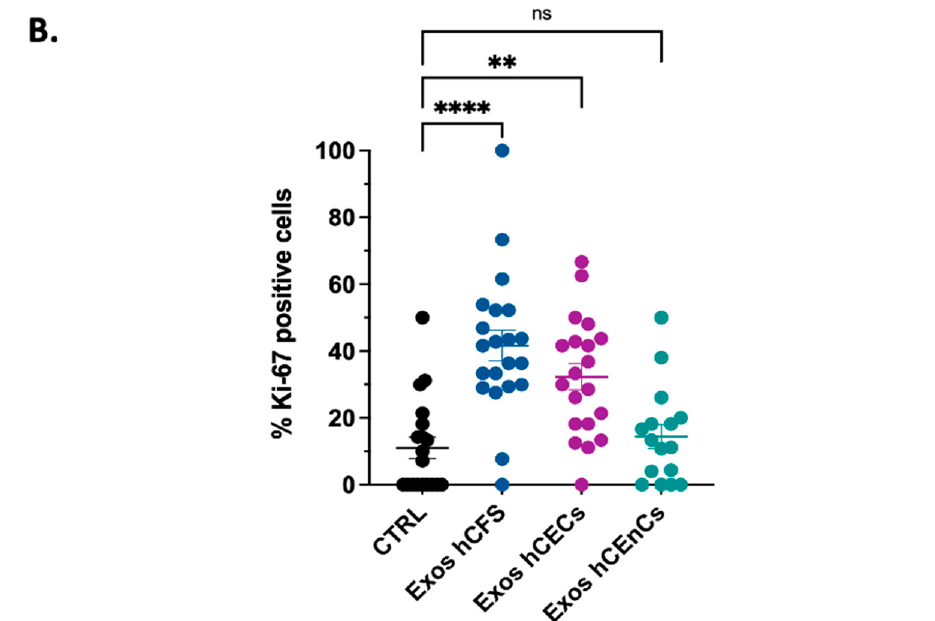
Figure 3. Effect of exosomes from the three corneal cell types on hCECs proliferation. hCECs were incubated with 800–1000 µ g exosomes isolated from medium of hCFs, hCECs and hCEnCs conditioned for 48 h. HBS was used as control (CTRL). Cells were fixed and Ki-67 was labeled by indirect immunofluorescence. Panel ( A ) shows representative images of Ki-67 expression in hCECs. Nuclei were counterstained with Hoechst 33258 reagent (blue). Scale bars: 100 µ m. ( B ) The number of Ki-67 positive cells was calculated and plotted on graph. Between four and eight photos per condition were used for the counts. The data is expressed as the mean ± SEM from three independent experiments on two different populations. ** p < 0.01, **** p < 0.001, ns: not significant.